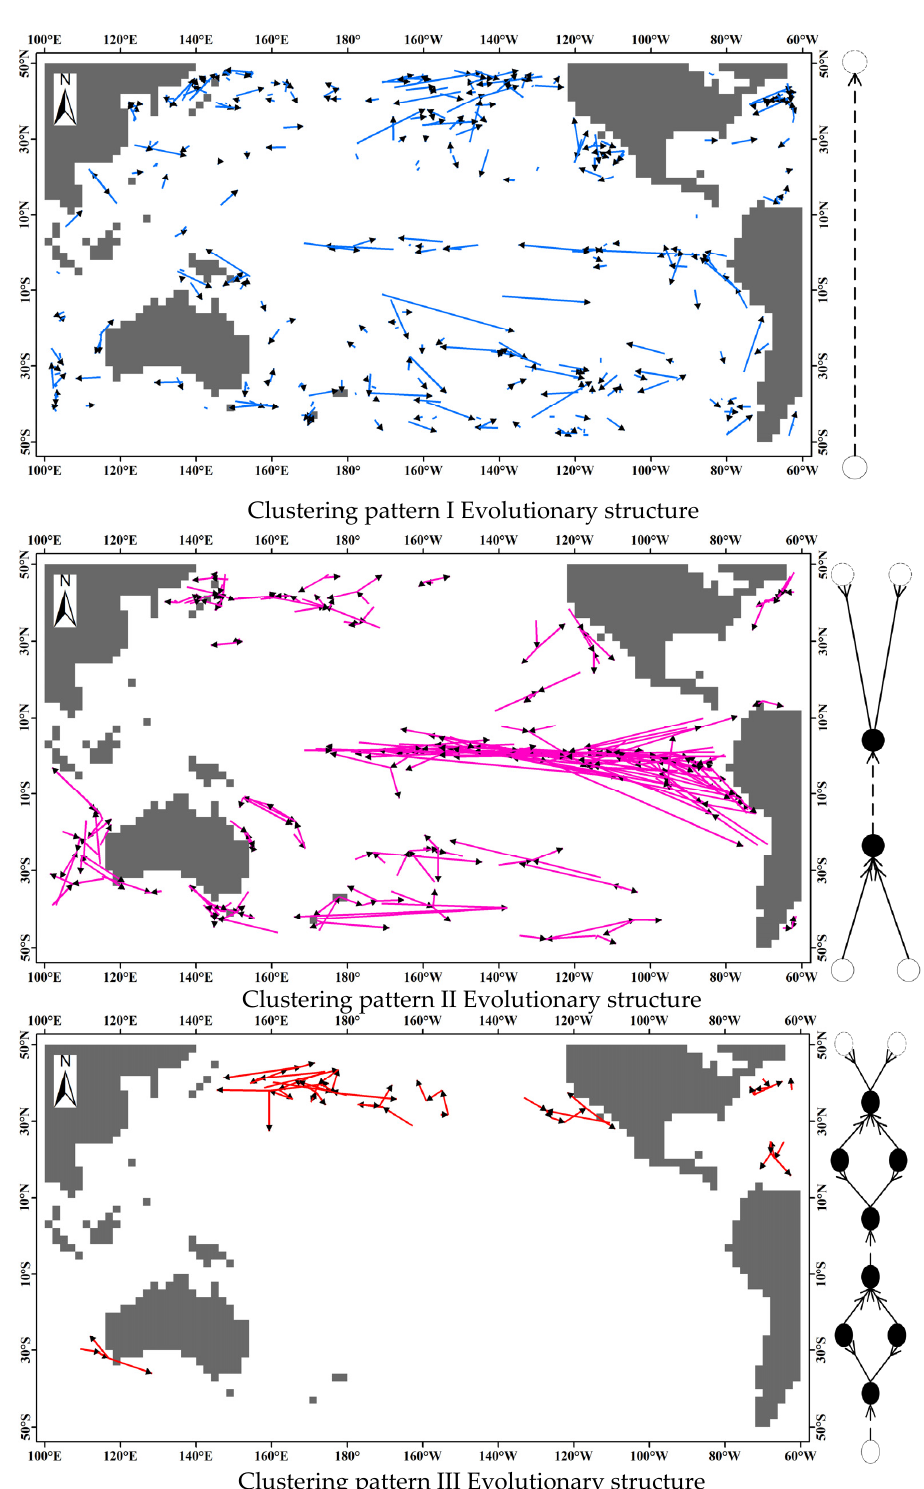
Figure 14. Clustering patterns in the Pacific Ocean, considering only thematic characteristics of process objects of SSTA.